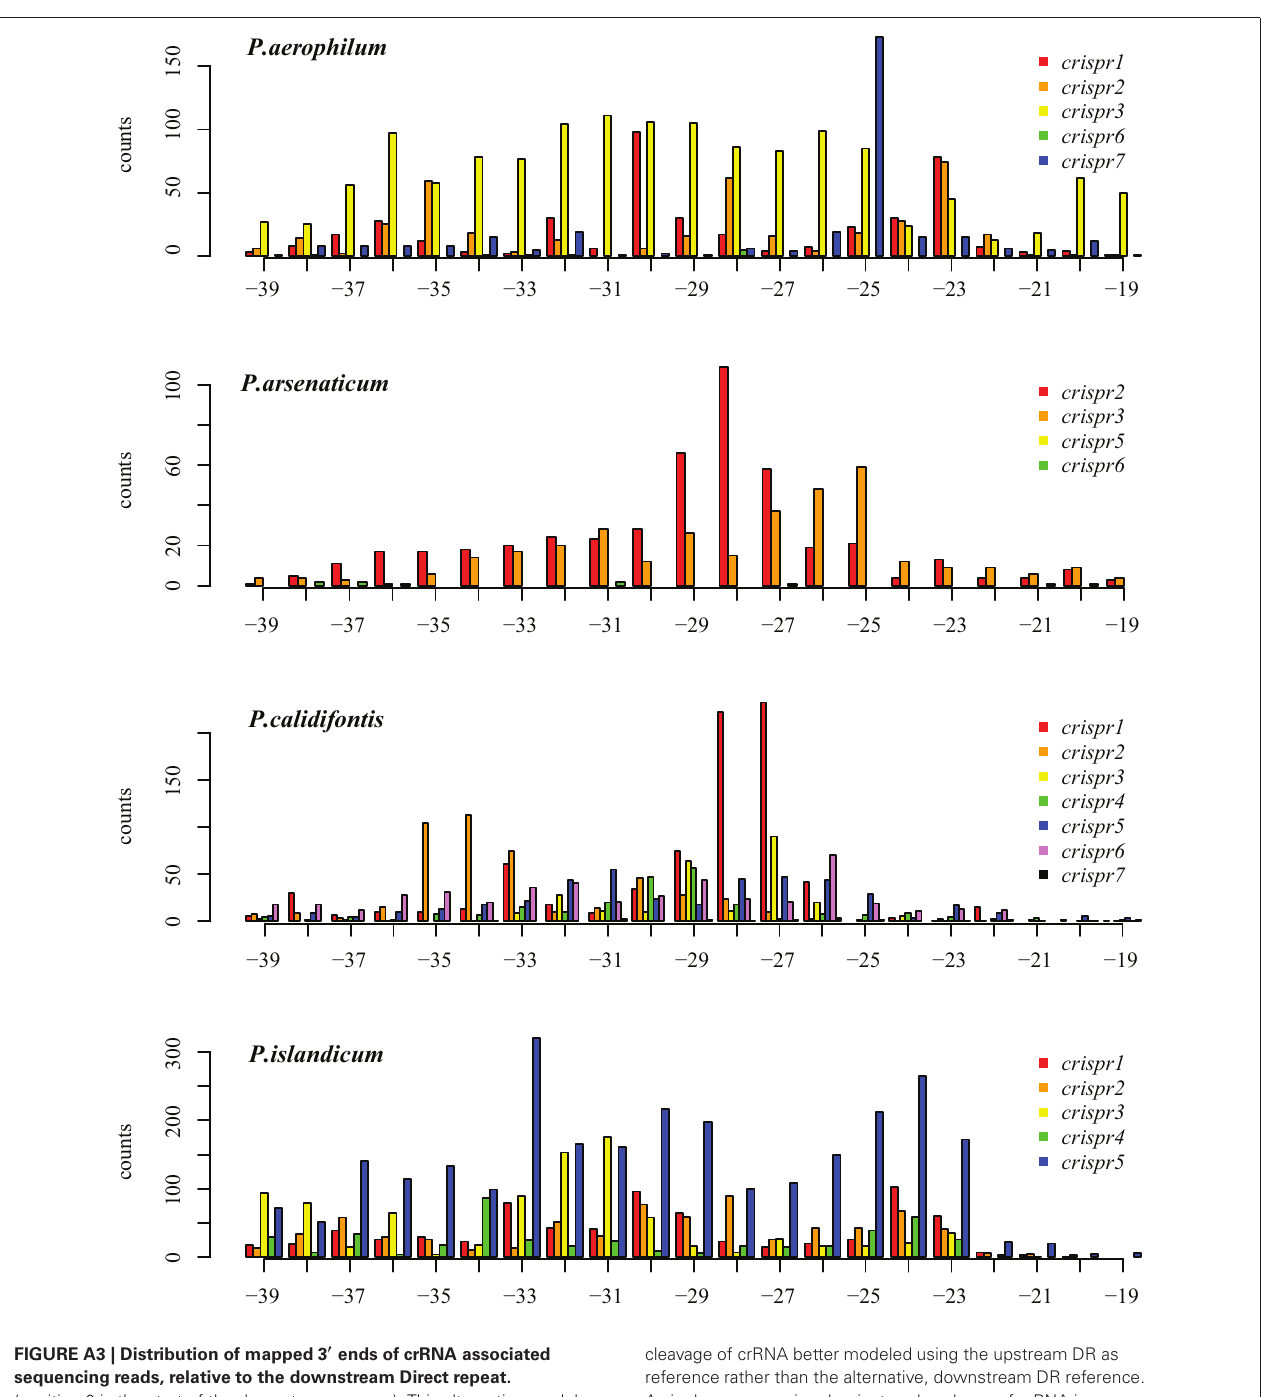
FIGURE A3 | Distribution of mapped 3 (cid:2) ends of crRNA associated sequencing reads, relative to the downstream Direct repeat. (position 0 is the start of the downstream spacer). This alternative model proposes that the downstream DR establishes the 3 (cid:2) cut site. In P. aerophilum , the major population of 3 (cid:2) ends shown for crispr 1–3 ( Figure A2 , position 40) is much more diffuse when measured in relation to the down stream direct repeat; this suggests that the 3 (cid:2)